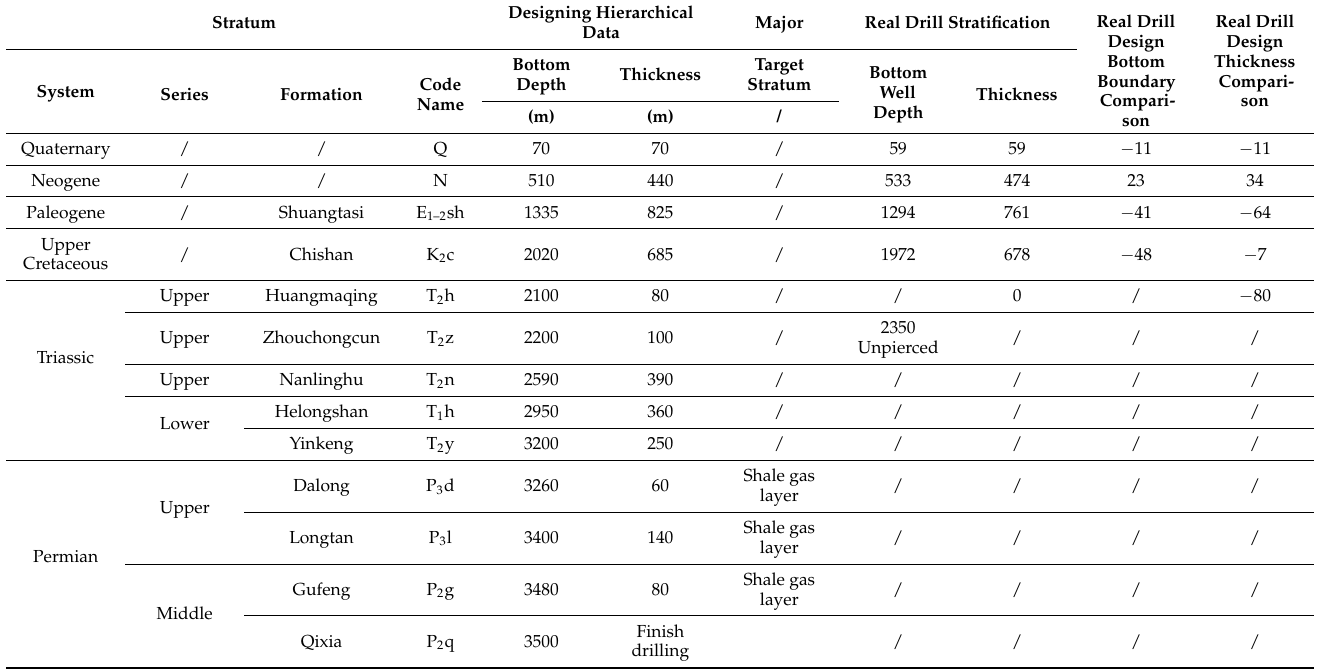
Table 1. Geological stratification of well